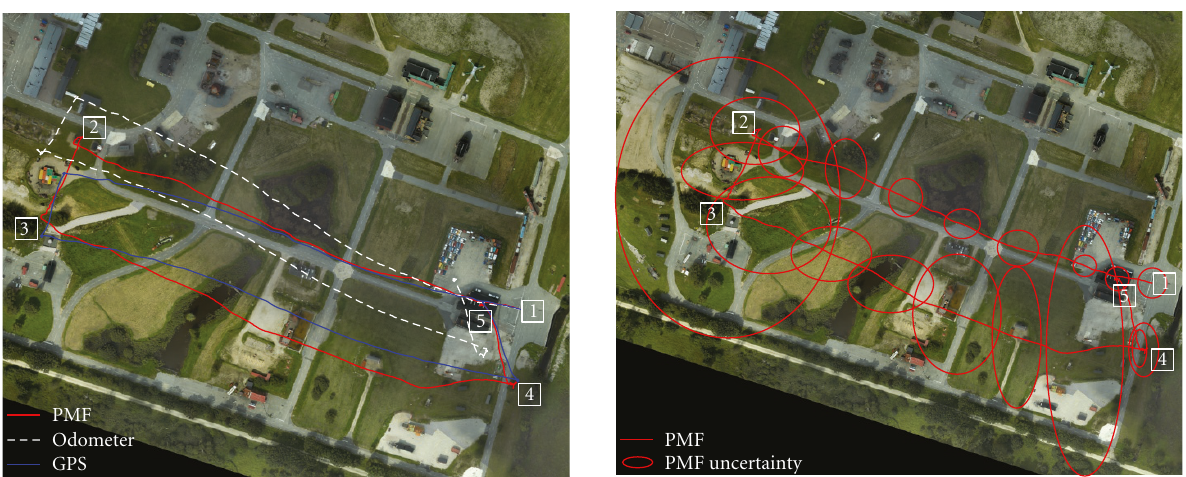
Figure 13: Vision-based navigation algorithm results in o ff -heading error conditions. The navigation filter is initialized with a 5-degree error in pitch, roll, and heading. While the pitch and roll angle converge to the right estimate rapidly, the heading does not converge to the right estimate a ff ecting the odometry and the image cross-correlation performed in o ff -heading